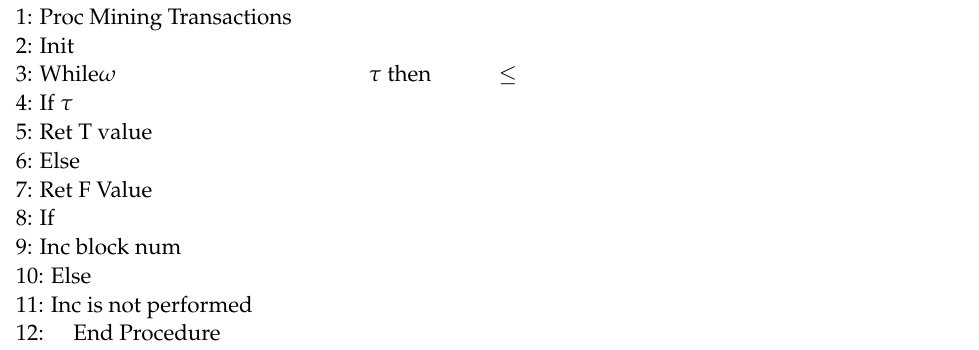
Algorithm 2 Algorithm Transaction Mining